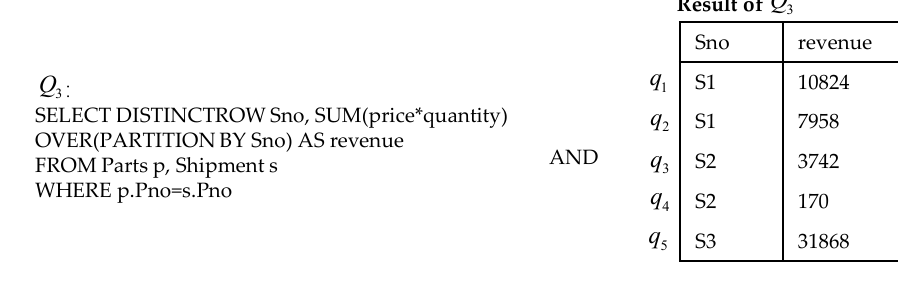
Figure 4. The query 𝑄 (cid:2871) and its output.